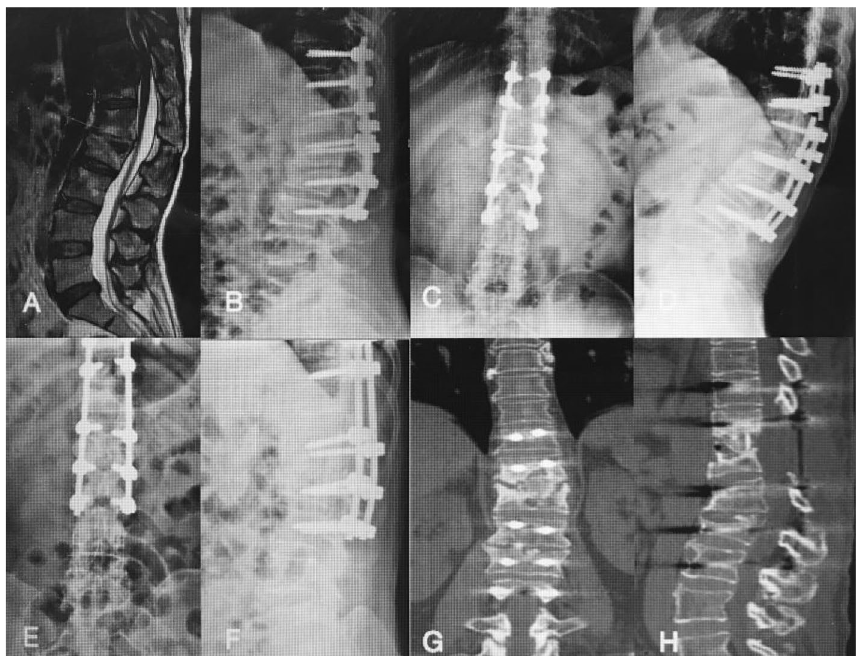
Figure 5. A 51-year-old woman with thoracic spinal tuberculosis (T11–12) underwent posterior debridement and decompression combined with instrumentation. ( A , B ) Preoperative computed tomography (CT) shows bone destruction of the T11–12 vertebrae and compression of the spinal cord. ( C , D ) The 2-year postoperative X-ray and CT demonstrate the bone was unhealed, and a rod fracture was observed. ( E – H ) The revision surgery was performed with an iliac graft. X-ray and CT show the good location of the bone